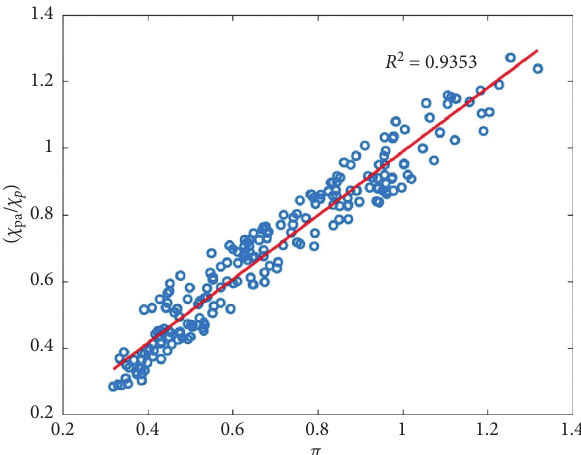
Figure 4: Comparison of the experimental data ( x